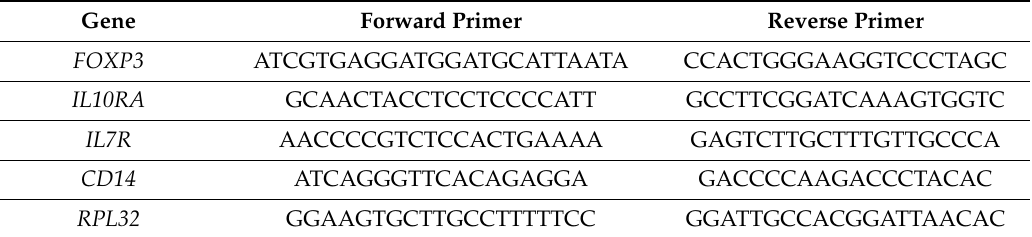
Table 3. Primers used for quantitative assessment of H3 or H4 histone